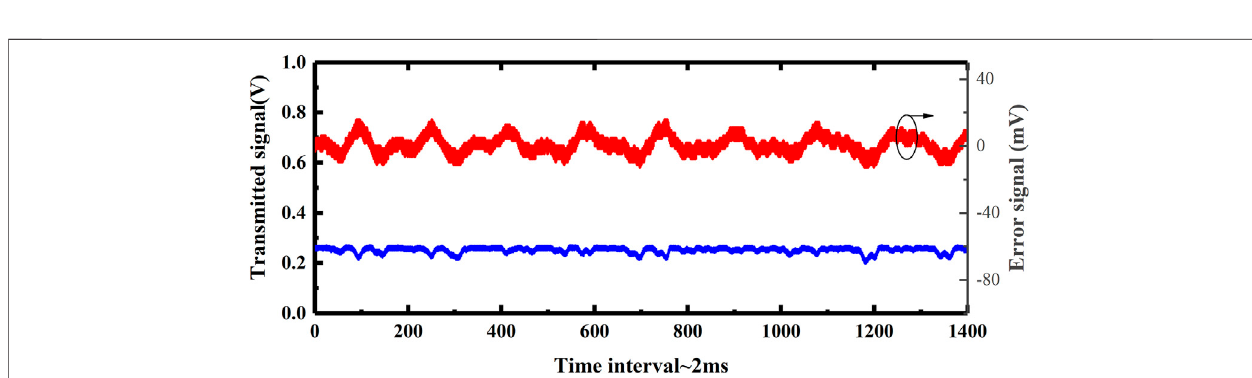
FIGURE 6 | Transmitted signal (blue) and error signal (red) of the PDH locked resonant cavity.